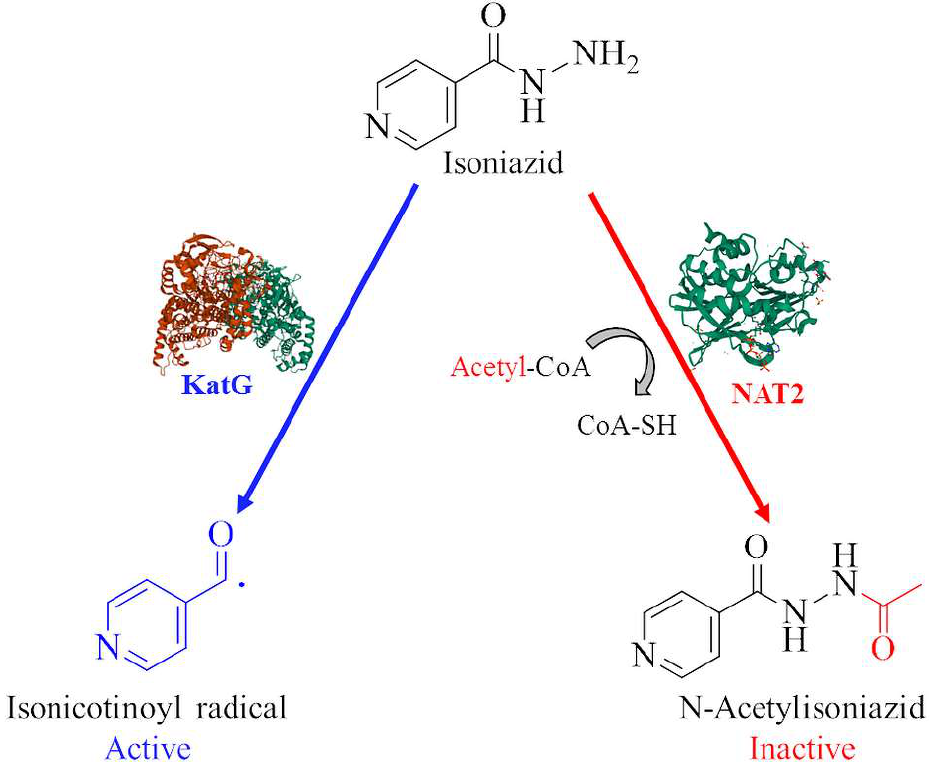
Figure 1. Schematic depiction of pathways leading to activation and inactivation of INH. Due to their commonly reported anti-TB properties, hydrazone-possessing molecules are of considerable interest [12]. Particularly, the synthesis of hydrazone derivatives of the current anti-TB drugs such as isoniazid [13], ciprofloxacin [14], and pyrazinamide [15] is a frequently applied antimycobacterial drug design strategy (Figure 2). Therefore, hydrazone is considered to be an excellent linker fragment for newly-designed antitubercular agents. As one of the most common ways to design and develop new drugs, molecular hybridization involves merging two or more pharmacophores in a single chemical entity, either directly or by using spacer units. The main goal of this strategy is to improve the biological profile while reducing side effects as much as possible